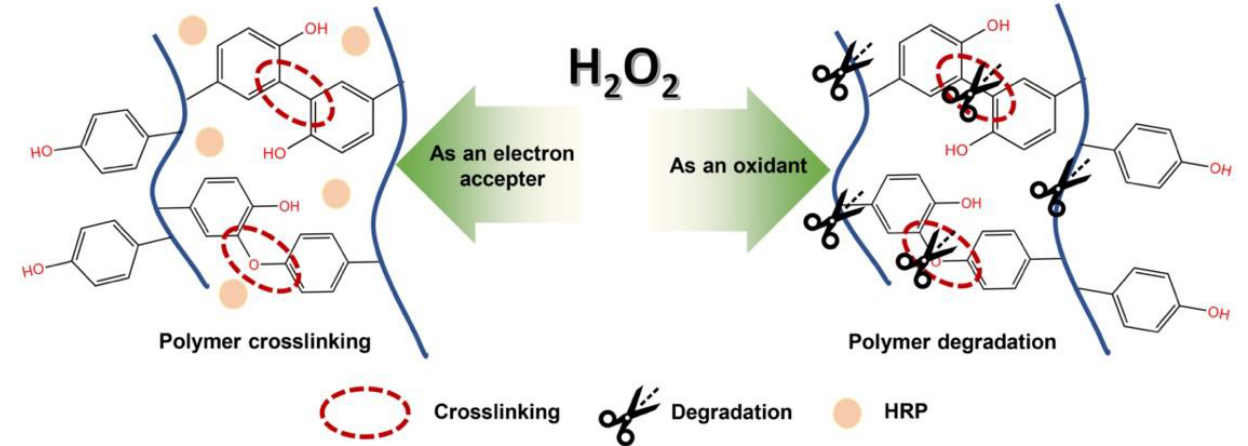
Figure 1. Schematic illustration of the H 2 O 2 -mediated crosslinking of phenolic groups on polymer chains catalyzed by HRP and degradation of the polymer chains.